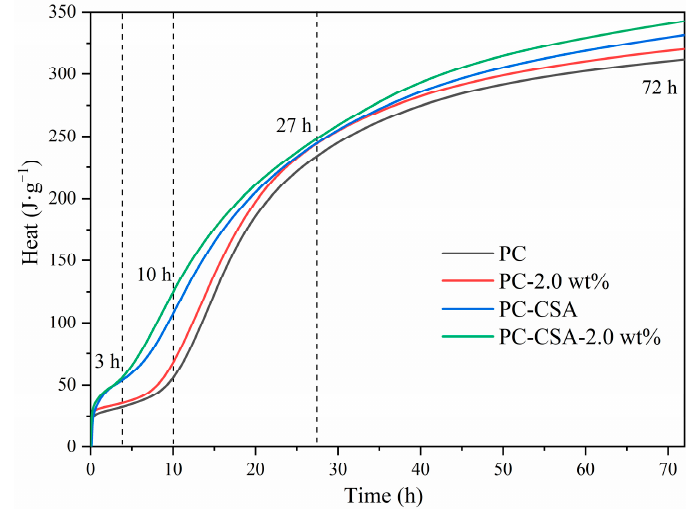
Figure 7. Cumulative hydration heat of different binders.